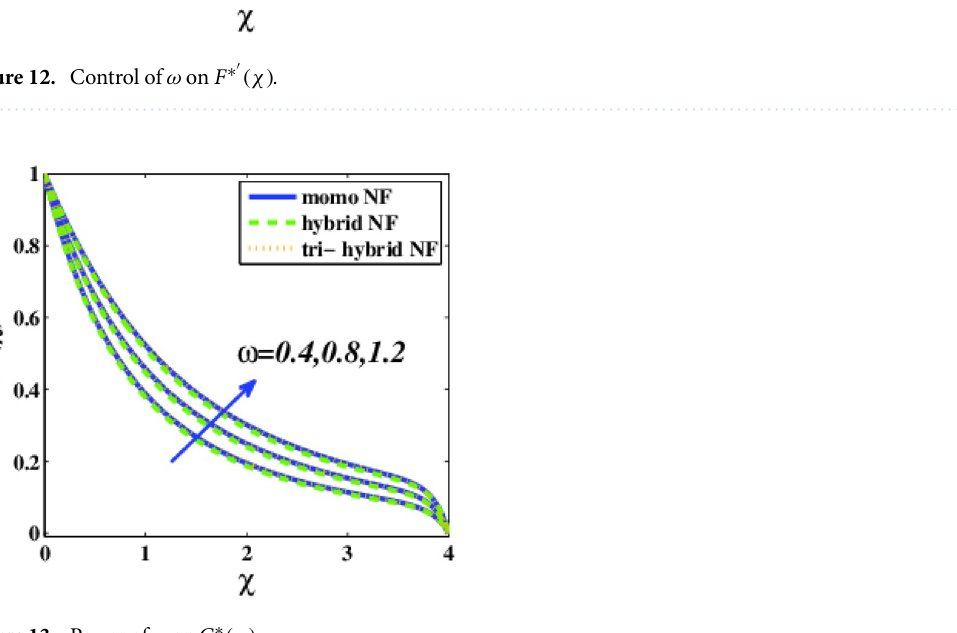
Figure 13. Power of ω on G ∗ (χ)